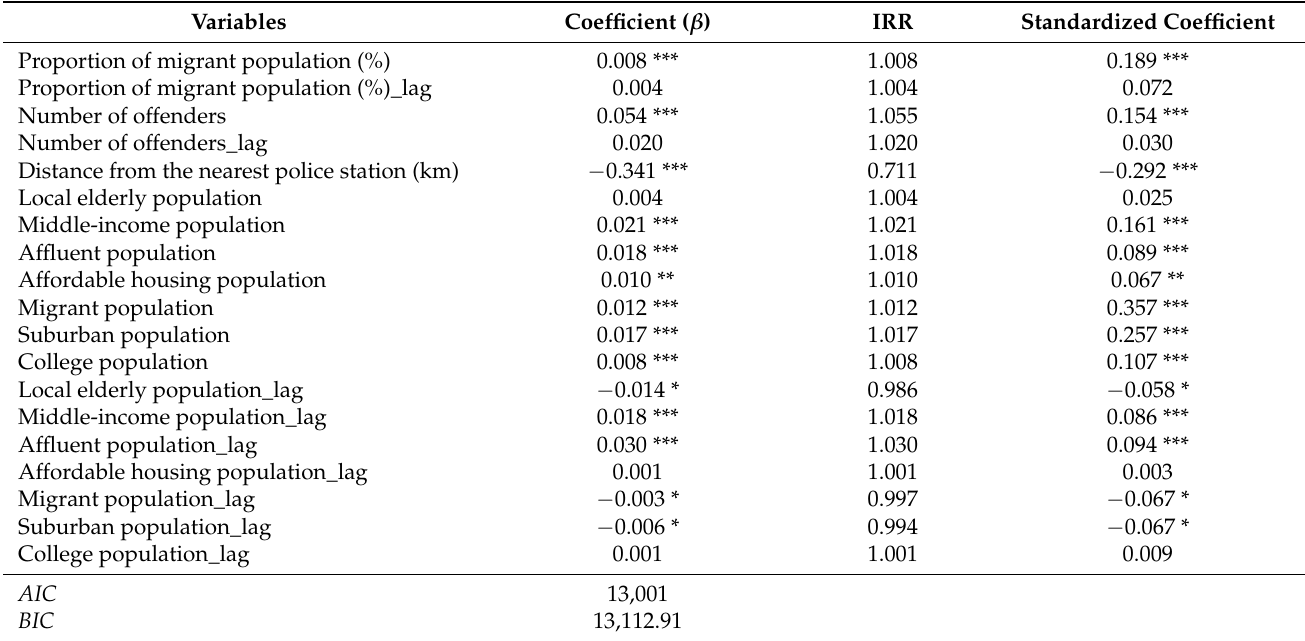
Table 4. Results of Spatial-lag negative binominal regression of ambient population from different communities (N =